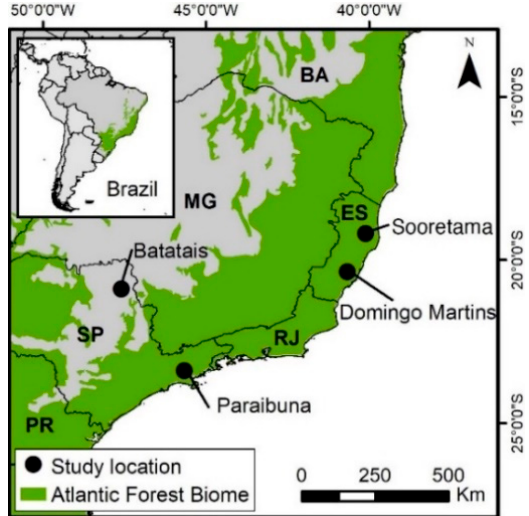
Figure 2. Map of Brazilian Atlantic Forest showing the four case study municipalities: Batatais and Paraibuna in the state of Sao Paulo, and Domingo Martins and Sooretama in the state of Espírito Santo.